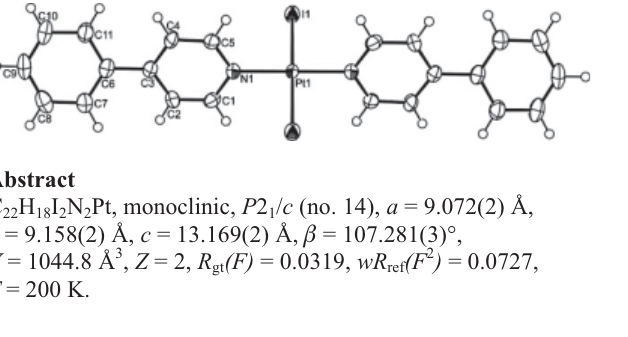
Table 1. Data collection and handling.